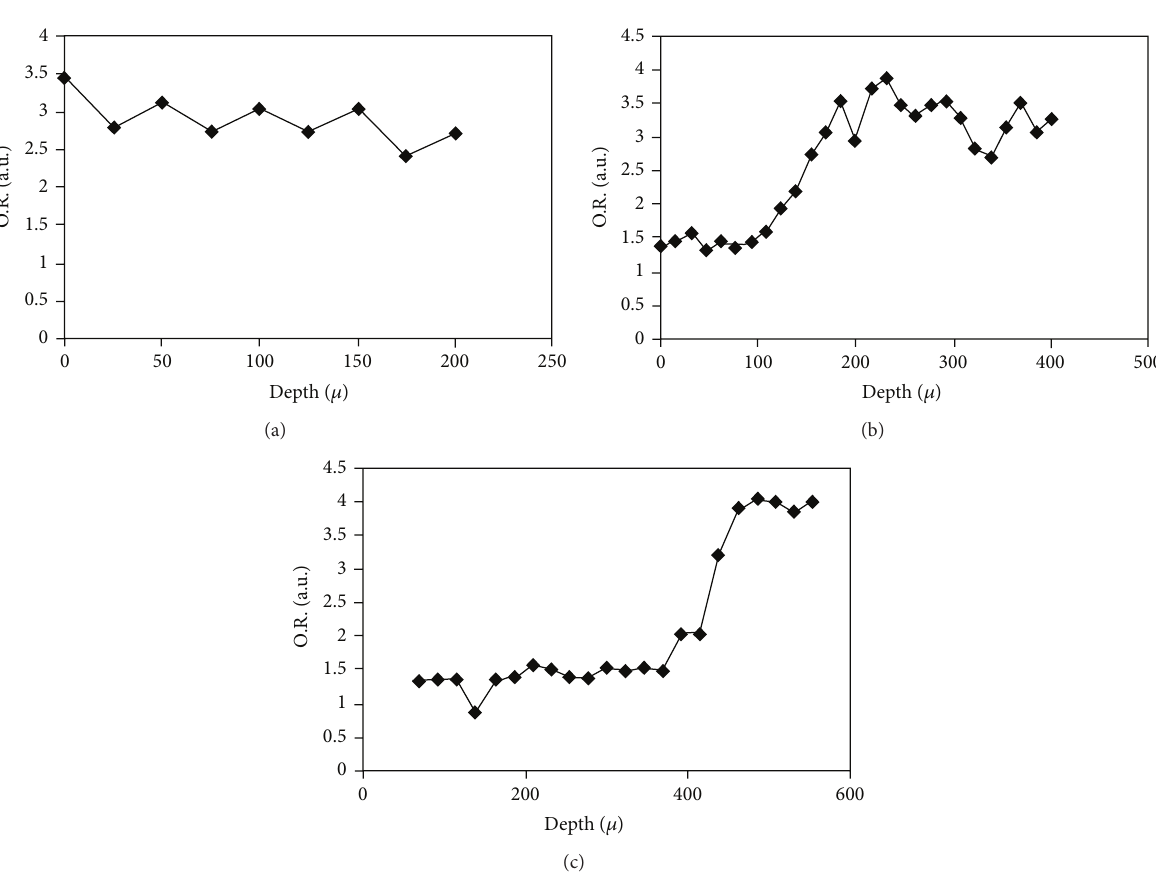
Figure 4: Line maps of O.R. profiles collected from the surface region of three different samples with (a) no, (b) medium level, and (c) high level of surface treatment.